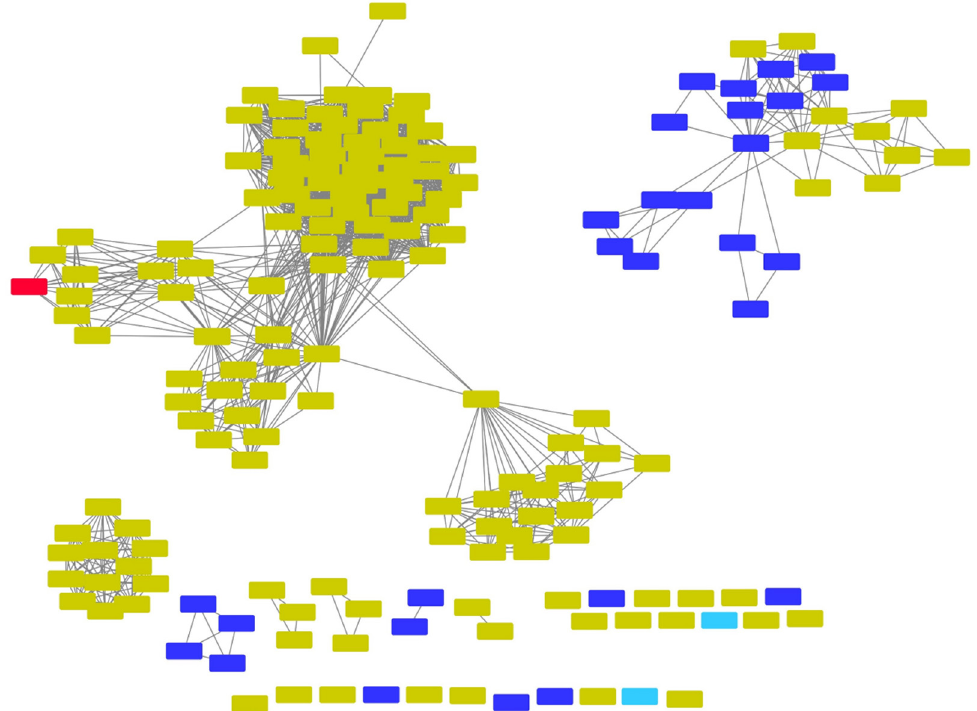
Figure 7. SSN showing putative NphB orthologs belonging to IPR036239 with at least 40% sequence identity to each other. Red: NphB (Q4R2T2) sequence; yellow for bacterial species, dark purple for other Eukaryota species, light blue for uncharacterized sequences.